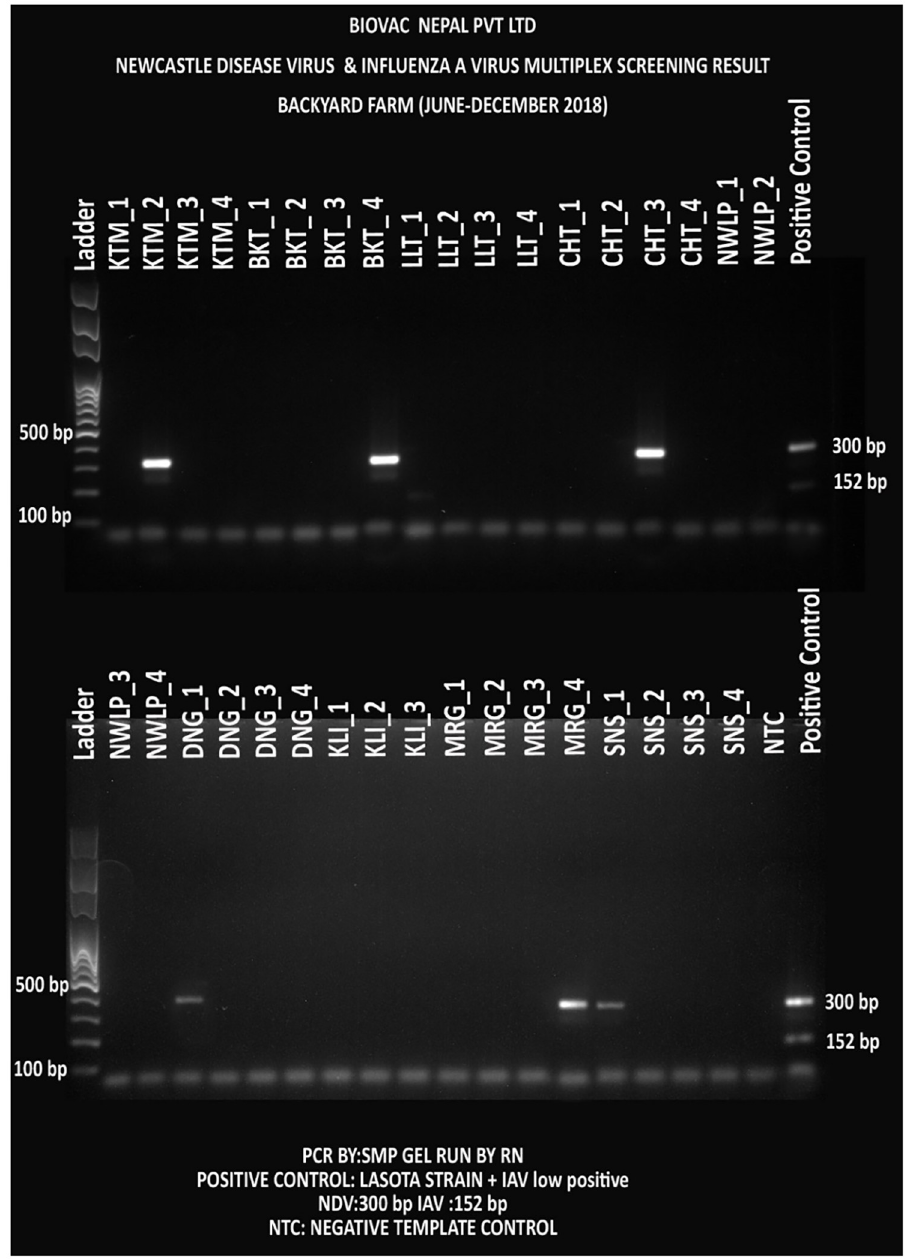
Fig 12. NDV and IAV screening PCR test in the backyard farms (n = 36)–NDV and IAV were detected with 300 bp and 152 bp PCR amplicons respectively. Each district were assigned with a three-letter code and had four farms (numbered 1 to 4). Each sample represents a farm pooled in a single tube and screened. The gel was run with ladder in the first well and negative and positive controls in the last wells (from left to right). KTM = Kathmandu, LLT = Lalitpur, CHT = Chitwan, NWLP = Nawalparasi, DNG = Dang, KLI = Kailali, MRG = Morang, and SNS = Sunsari Districts.